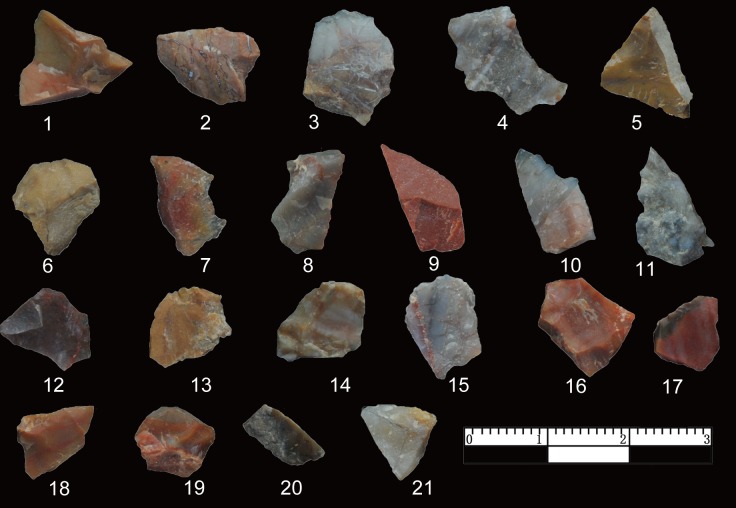
Shatter from DGT.Shatter is typically smaller than 25 mm. Shatter have no clear sign of conchoidal percussion and it is often difficult to distinguish upper and lower faces.